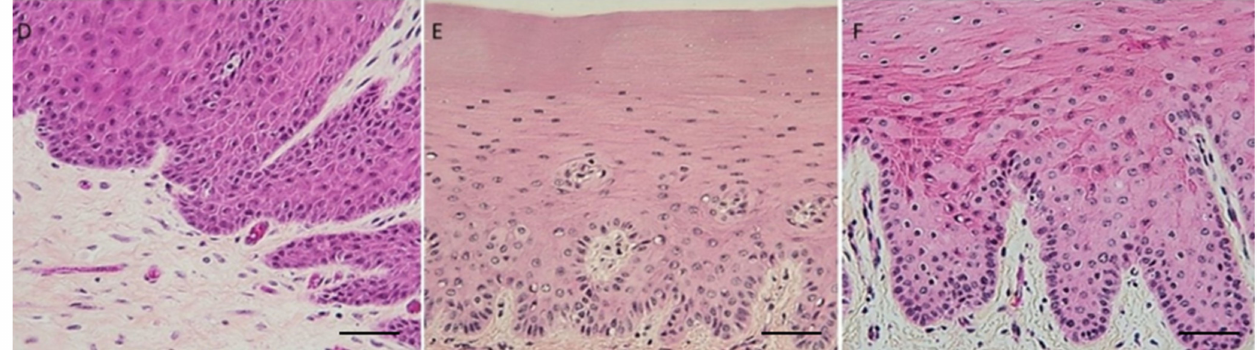
Figure 3. Cows teeth and periodontal tissue. ( A ) Cow tooth decalcified with Anna Morse’s solution, 100 × scale bare 100 µ m H&E staining. ( B ) Cow tooth decalcified with EDTA-MW, 100 × scale bare 100 µ m H&E staining. ( C ) Cow tooth decalcified with EDTA-MW for 90 days, scale bare 100 µ m H&E staining. It is possible to recognize pulp tissue in the upper part of the images, odontoblast attached to the canal walls, and dentin with its characteristic dentin tubules. Dentin is composed of pre-dentin, a lighter shade of pink, and dentin, a darker shade of pink. ( D ) Periodontal tissue treated with Anna Morse’s solution scale bare 100 µ m H&E staining. ( E ) Periodontal tissue treated with EDTA-MW scale bar 100 µ m H&E staining. ( F ) Periodontal tissue treated with EDTA-MW for 90 days scale bare 100 µ m H&E staining. It is possible to distinguish the pluristratified keratine cell layer in the upper part of the images, stained in purple, and the connective tissue below dyed in orange.